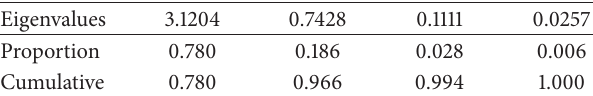
Table 12: VIKOR output for product 𝐵